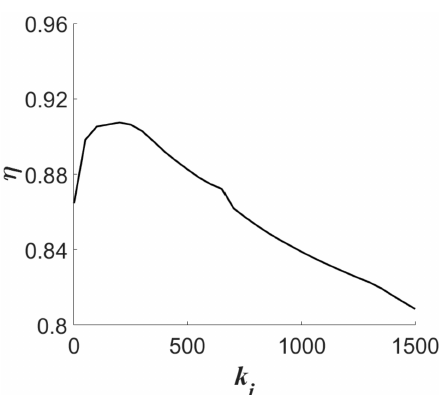
Figure 13. The variation of efficiency of the five NESs with nonlinear stiffness.